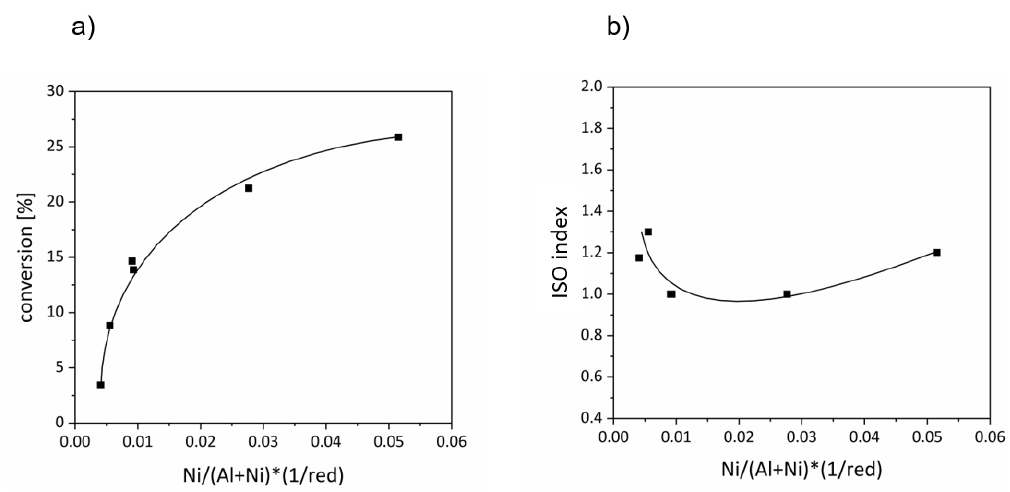
Figure 3. ( a ) Conversion of n-butenes and ( b ) ISO index depending on the product of Ni/(Al + Ni) ratio and 1/red.